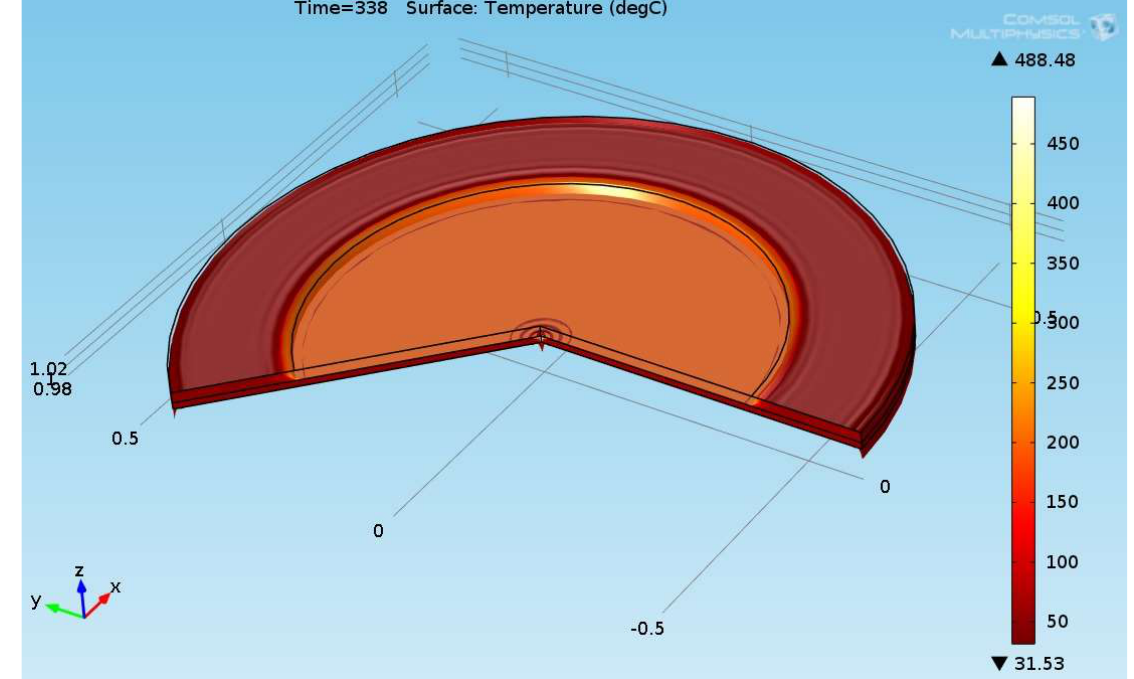
Figure 14. 3D temperature field of the Composite lining and the Steel casing.